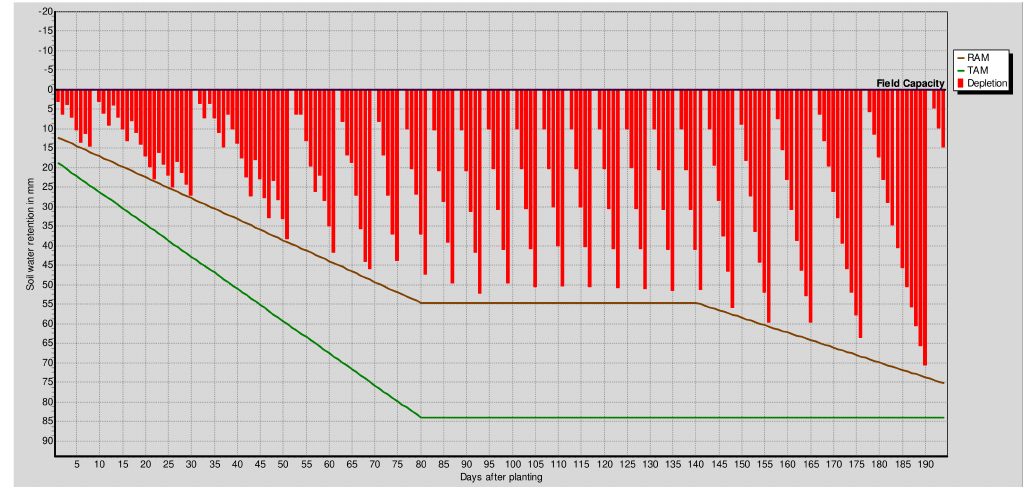
Figure 14. Irrigation schedule for cotton at site 5 ( x -axis shows days after planting and y -axis shows soil water retention in mm). TAM = total available moisture; RAM = readily available moisture.